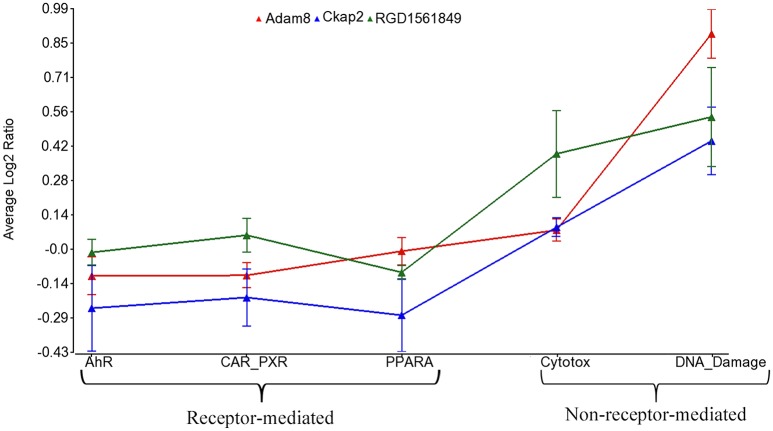
Profile plot of significantly different genes between RM and NRM samples. Gene expression profile plot of the top 3 of 17 genes determined to be statistically significant between RM and NRM samples (p < 0.05). The x-axis is the MOAs, the y-axis is the MOA average of the log base 2 ratio data [treated samples (the average of all three replicates for each chemical within a MOA) to the average of the controls matched according to nutritional status of the vehicle and route of administration]. The gene expression profiles are colored as shown in the figure legend. The variation in the data points from the average of the chemicals in a MOA is represented by standard error bars.